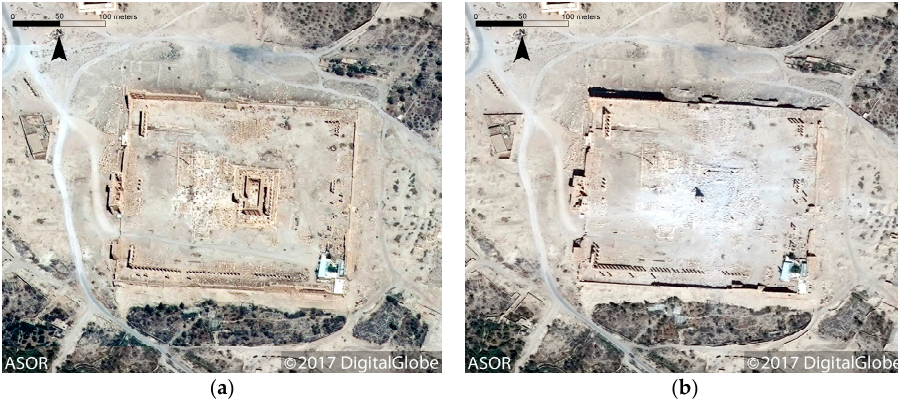
Figure 6. DigitalGlobe satellite imagery of the Temple of Bel: ( a ) prior to intentional destruction (DigitalGlobe NextView License; 26 June 2015); ( b ) post-destruction with the cella of the temple destroyed (DigitalGlobe NextView License; 2 September 2015).